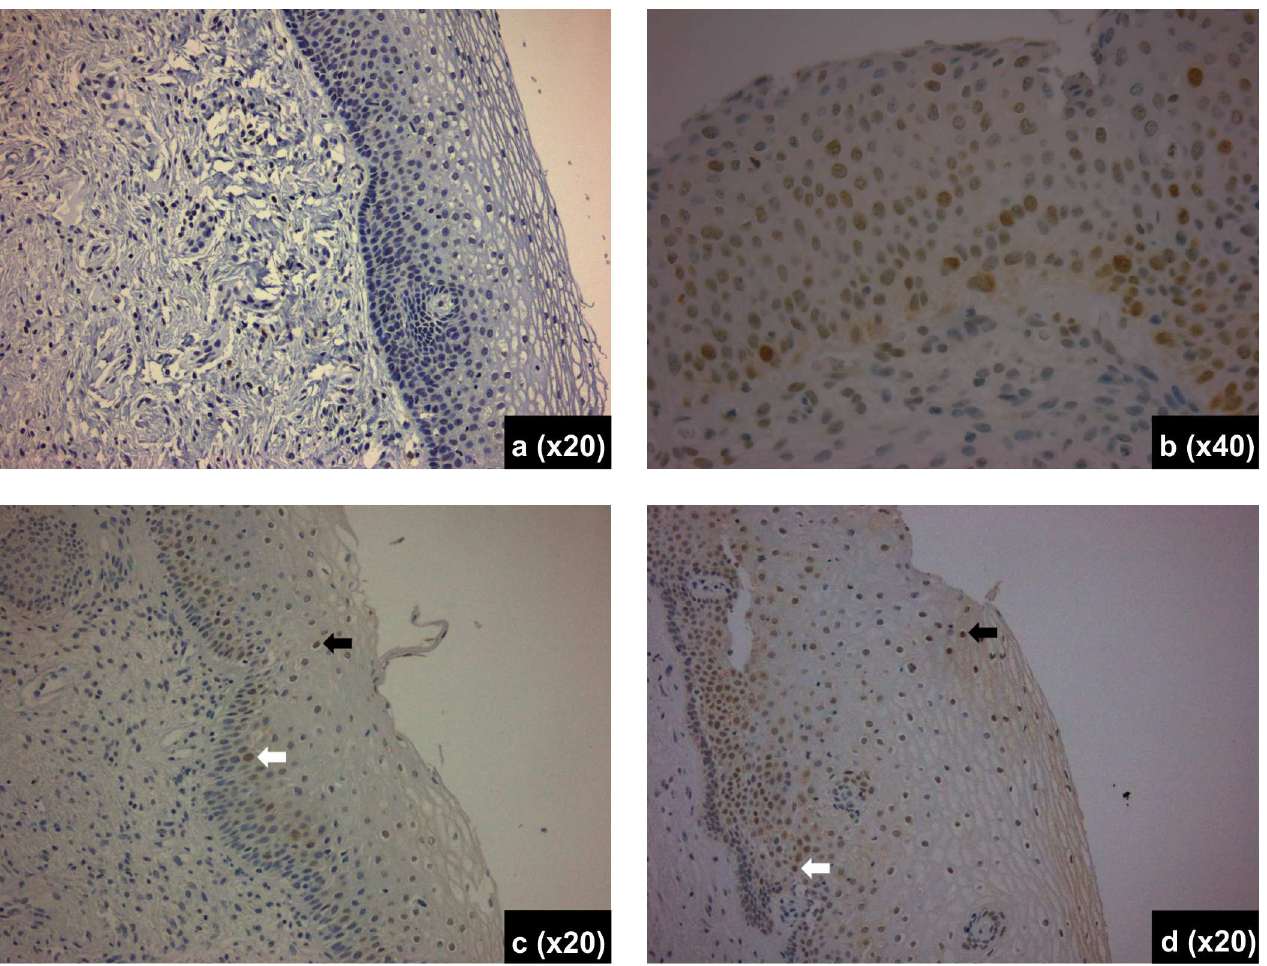
Fig 3. γ 2 ΗΑΧ immunostaining of histological sectionsfrom the followingcases: control (a); HGSIL (b); LGSIL harboringHigh Risk HPV at an activated state (c); and LGSIL harboringHigh Risk HPV at a non activated state (d). In pictures c and d, arrows depict positive cell (nuclearstaining) at basal (white arrow) and surface (black arrow) area of the epithelium. Objective magnifications appearon pictures.